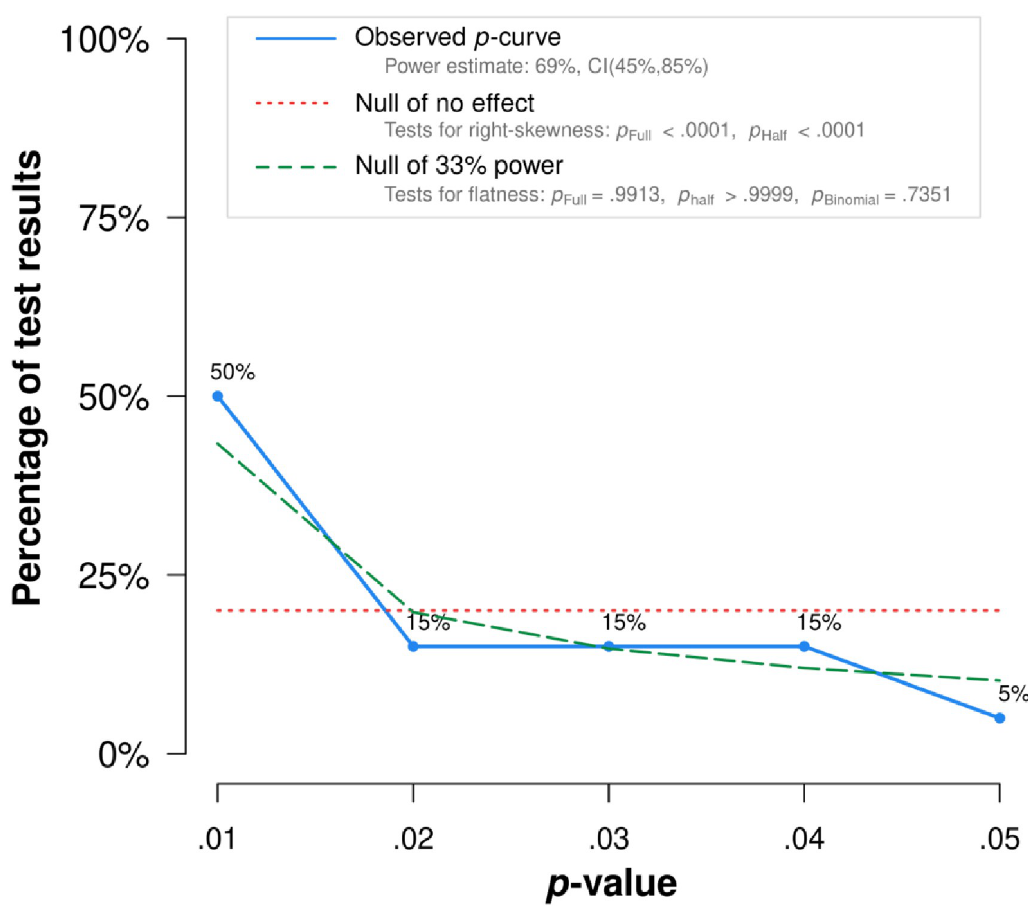
Fig 2. P -curve plot for studies on negative affect and alcohol consumption. Note: The observed p -curve includes 20 statistically significant ( p < .05) results, of which 15 are p < .025. There were 107 additional results entered but excluded from p -curve because they were p >